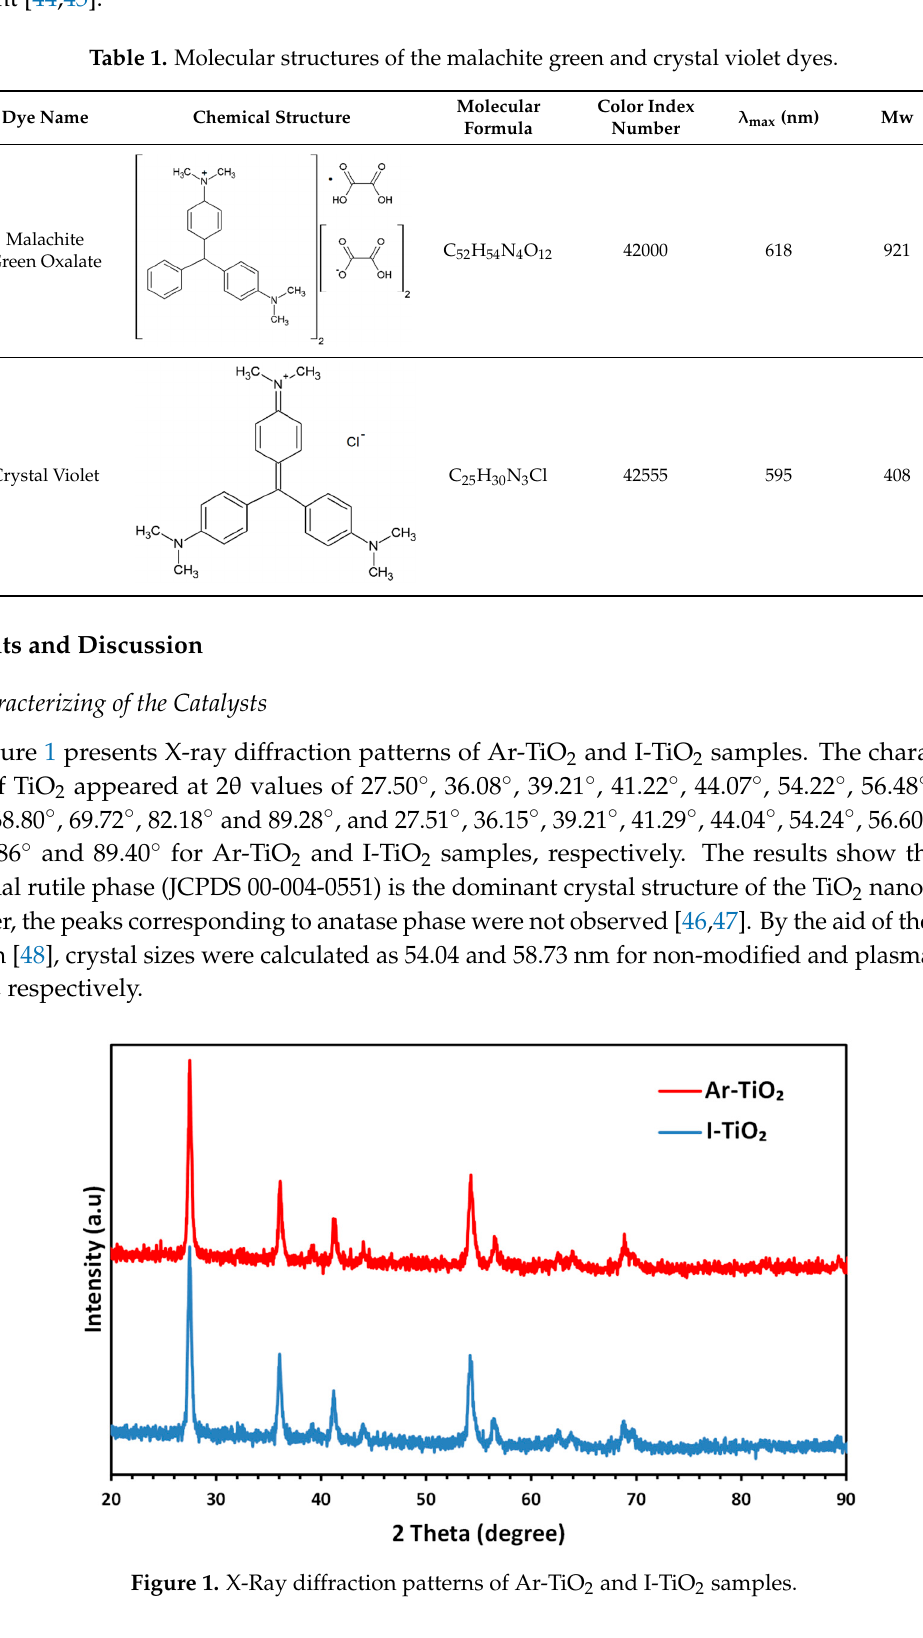
Figure 1. X-Ray diffraction patterns of Ar-TiO 2 and I-TiO 2 samples.